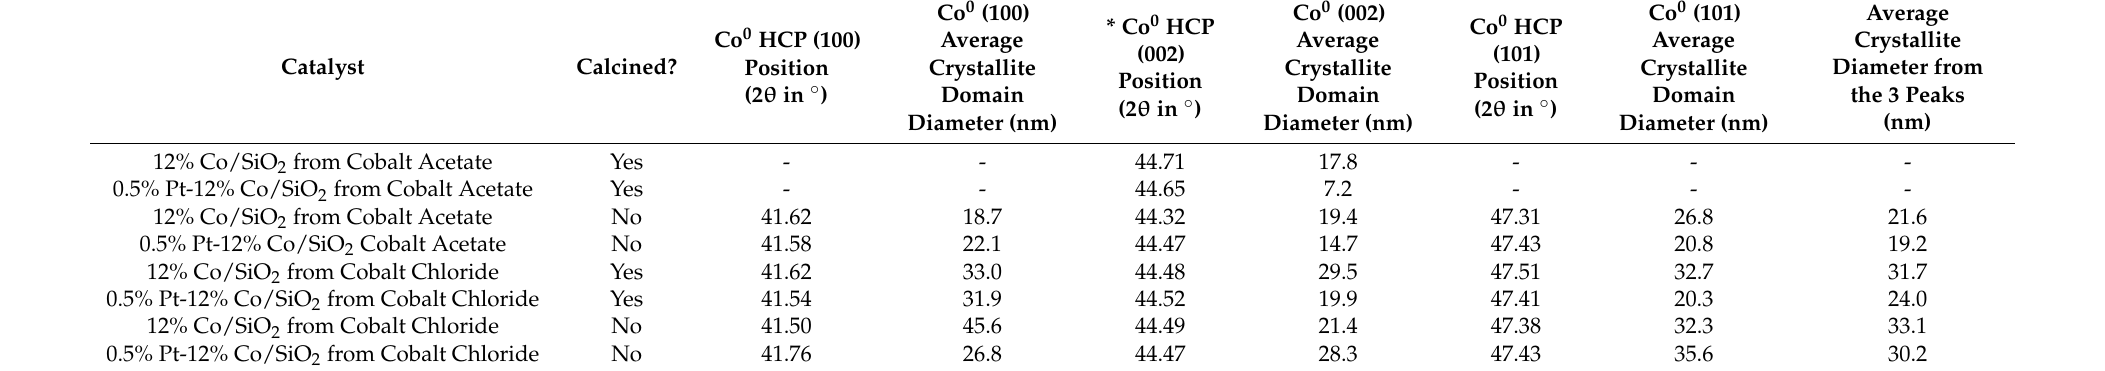
Table 4. Results of X-ray diffraction from the integral breadth